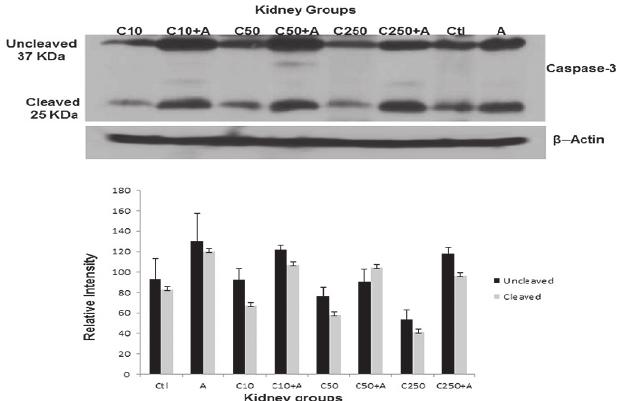
10 mg/kg + adenine, chrysin 50 mg/kg, chrysin 50 mg/kg + adenine, chrysin 250 mg/kg, chrysin 250 mg/kg + adenine, saline (control), and adenine using Western blot analysis. The graph in panel B represents the densitometry measurement of both the un-cleaved and cleaved caspase-3 bands in kidney homogenates from all treated and non-treated